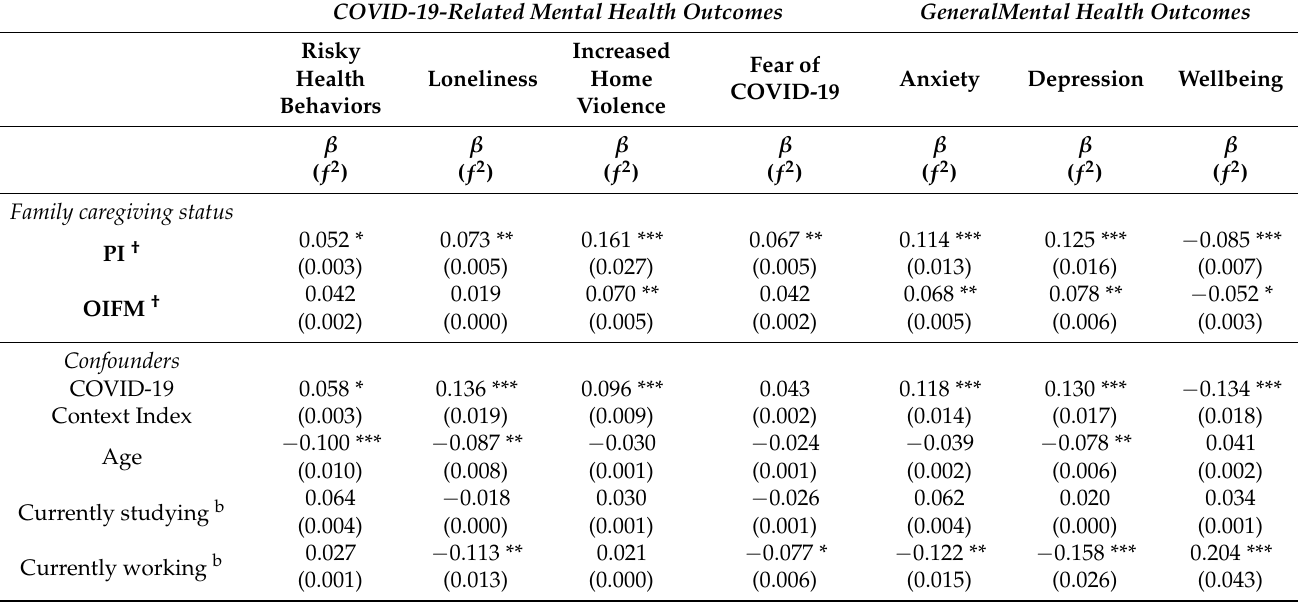
Table 4. Multivariate regressions predicting mental health